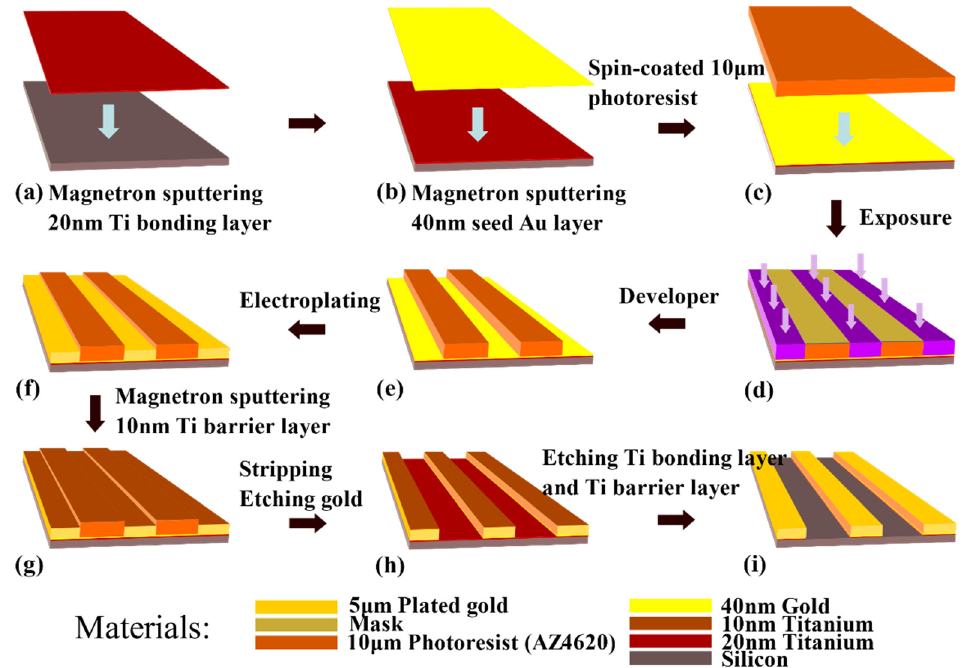
Figure 3. Thick film micro-nano fabrication process with controllable surface roughness.